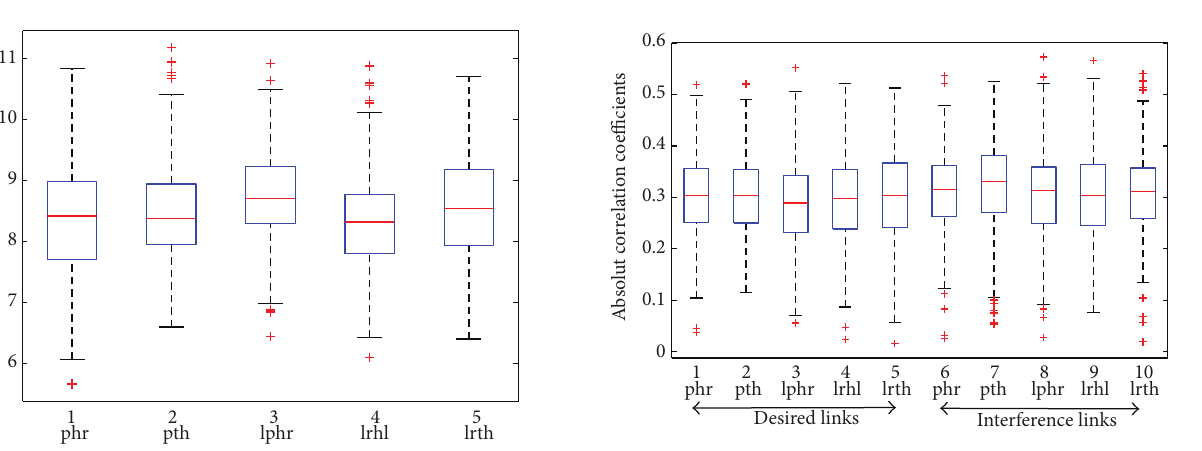
Figure 8: Correlation coefficients for different grips at low